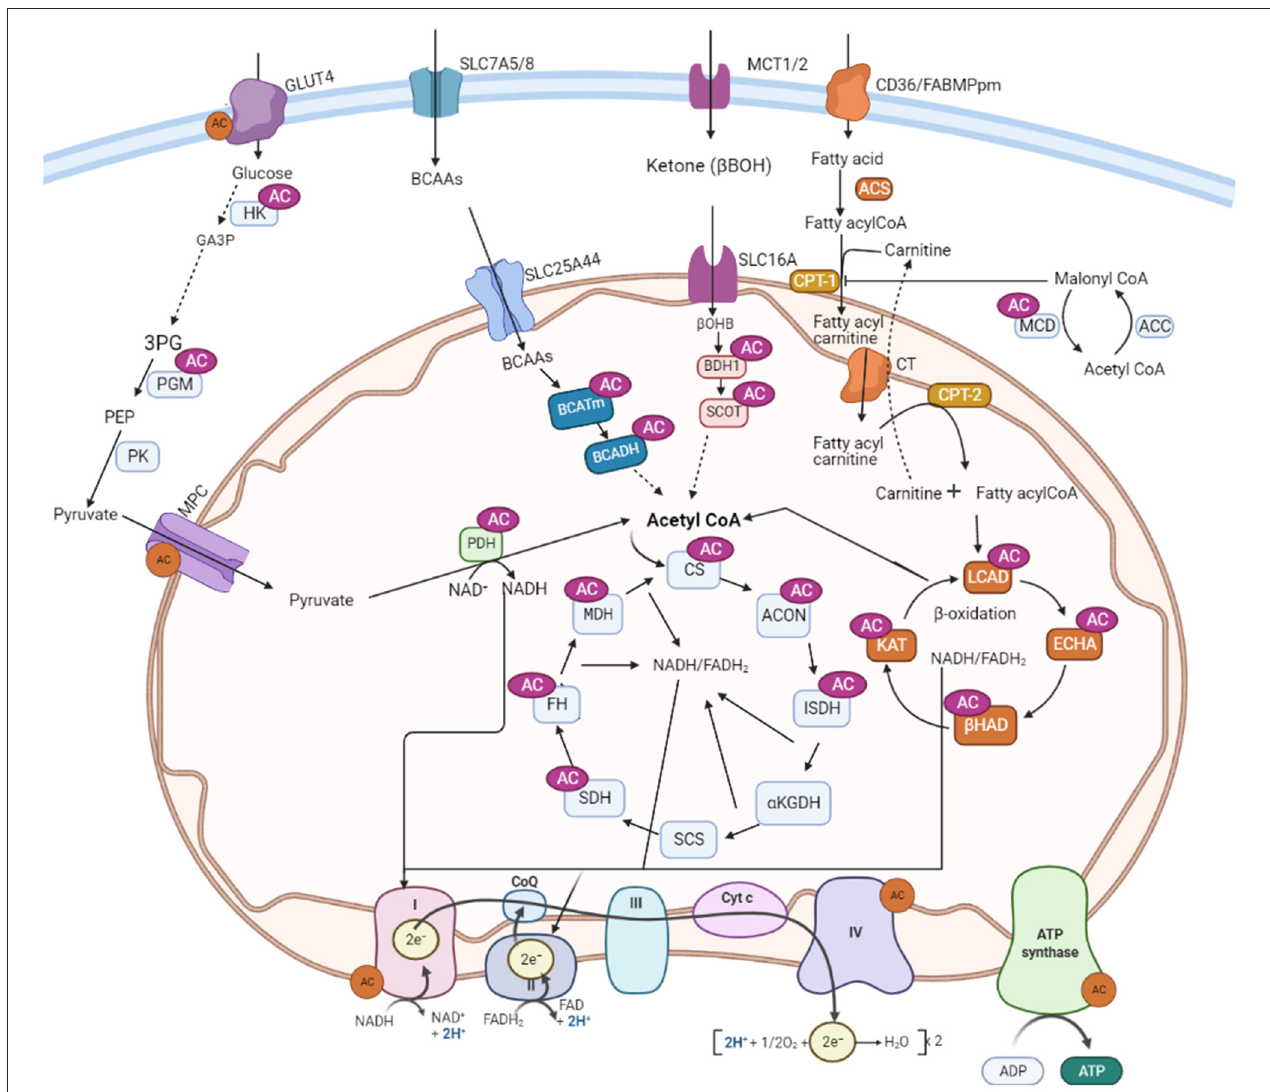
FIGURE 2 | Metabolic proteins subjected to acetylation control in the heart. AC, lysine acetylation; GLUT4, glucose transporter isoform 4; SLC7A5/8, solute carrier family-7; SLC25A44, solute carrier family-25; SLC16, solute carrier family-16; MCT, monocarboxylate transporter 1; CD36, cluster of differentiation 36; FABPpm, plasma membrane fatty acid-binding protein; MCD, malonyl CoA decarboxylase; ACC, acetyl CoA carboxylase; PDH, pyruvate dehydrogenase; LCAD, long-chain acyl CoA dehydrogenase; β -HAD, β -hydroxyacyl CoA dehydrogenase; KAT, 3-ketoacyl-coa thiolase; ECH, enoyl-CoA hydratase; FAS, fatty acyl CoA synthase; CPT-1, carnitine palmitoyltransferase 1; CPT-2, carnitine palmitoyltransferase-2; CT, carnitine acyl translocase; BCAA, branched-chain amino acids; BCATm, mitochondrial branched-chain aminotransferase; BCADH, branched-chain amino acid dehydrogenase; β -OHB, β -hydroxybutyrate; BDH-1, 3-hydroxybutyrate dehydrogenase 1; SCOT, 3-ketoacid CoA transferase; CS, citrate synthase; ISDH, iso-citrate dehydrogenase; α -KGDH, alpha-ketoglutarate dehydrogenase; SCS, succinate CoA synthetase; MDH, malate dehydrogenase; SDH, succinate dehydrogenase; FH, fumarate hydratase; OAA, oxaloacetate; MCD, malonyl CoA decarboxylase;